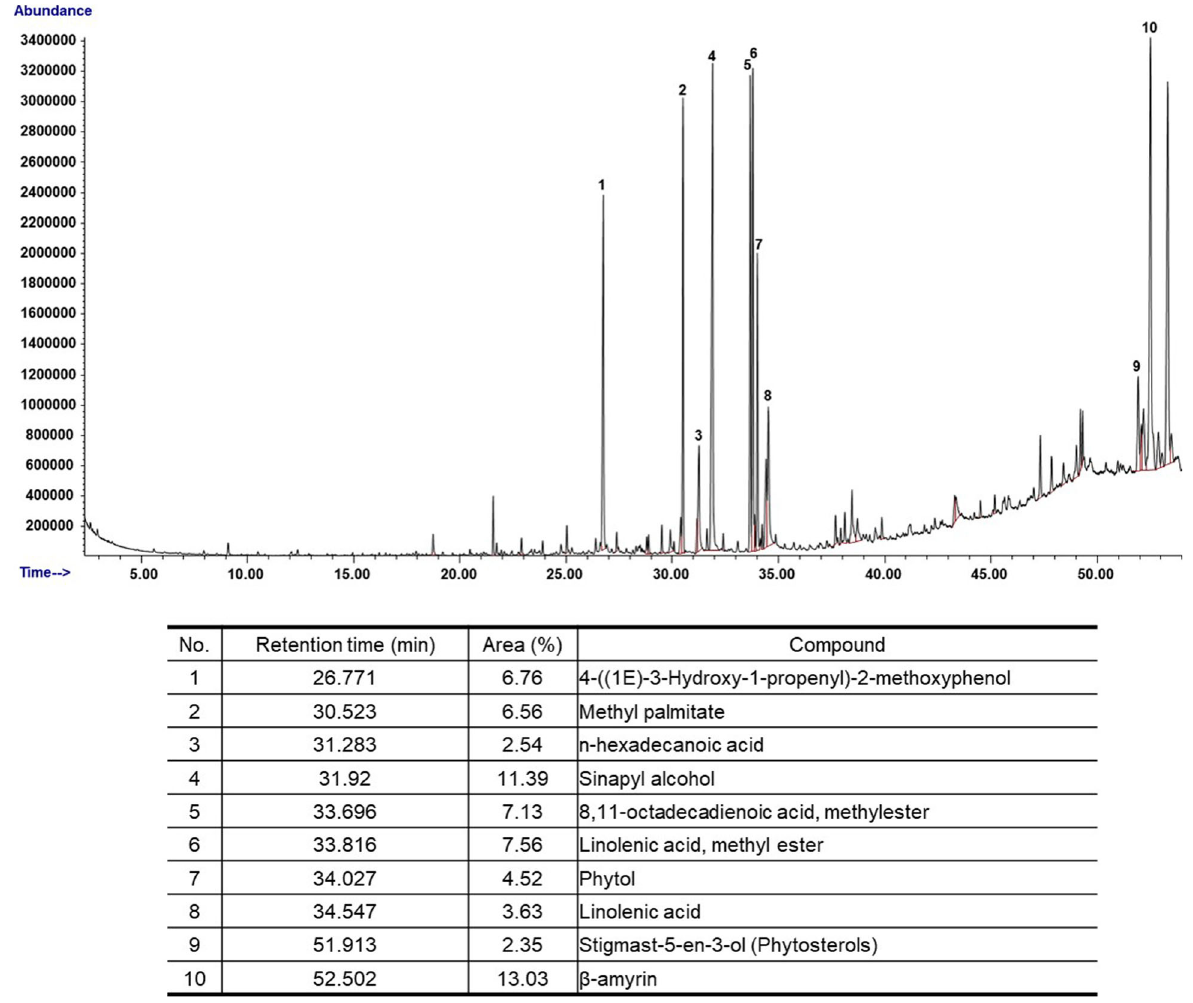
Fig. 1 Chromatography of GC/MS analysis of VOS. The major compounds from VOS were analyzed using GC/MS as described in Materials and